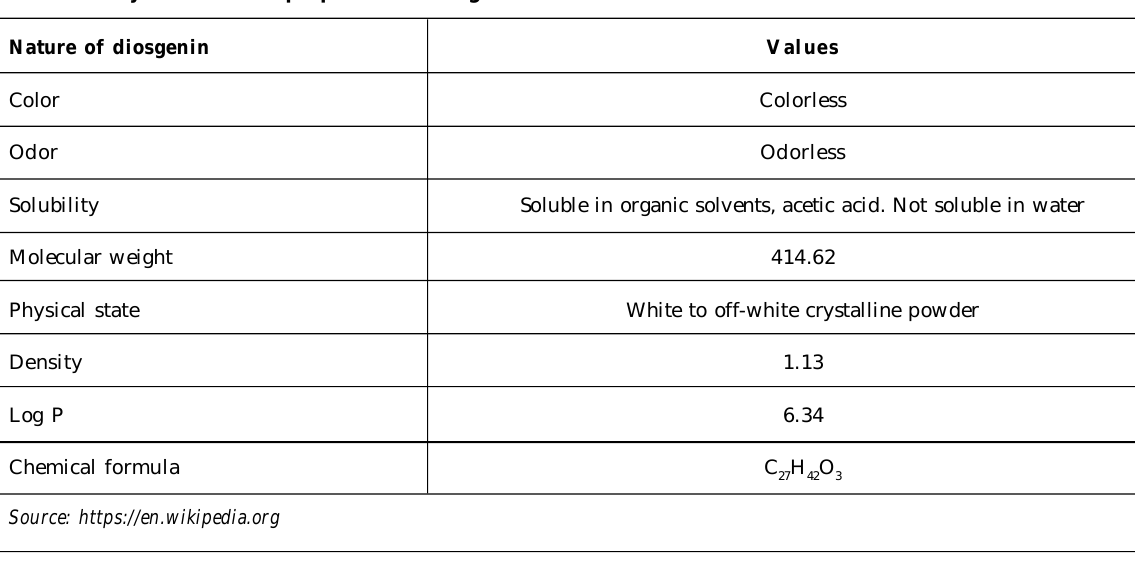
Table 1: Physico chemical properties of